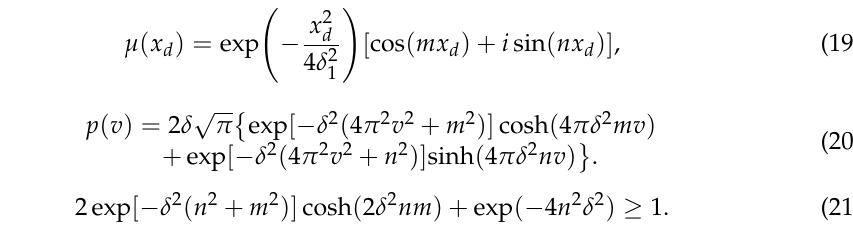
Figure 2. The source coherence states were calculated from Equation (16) and far-field spectral densities calculated from Equation (17) for different values of the source parameters: ( a – c ) δ 1 = 0.15mm, δ 3 = 0.5mm, m = 9 π /10, n = π /10; ( d – f ) δ 1 = 0.45mm, δ 3 = 0.5mm, m = 9 π /10, n = π /10; ( g – i ) δ 1 = 0.45mm, δ 3 = 0.5mm, m = 9 π /10, n = 3 π /4. When δ 1 = δ 3 = δ and A 1 = A 3 = A , Equations (16)–(18) have the following